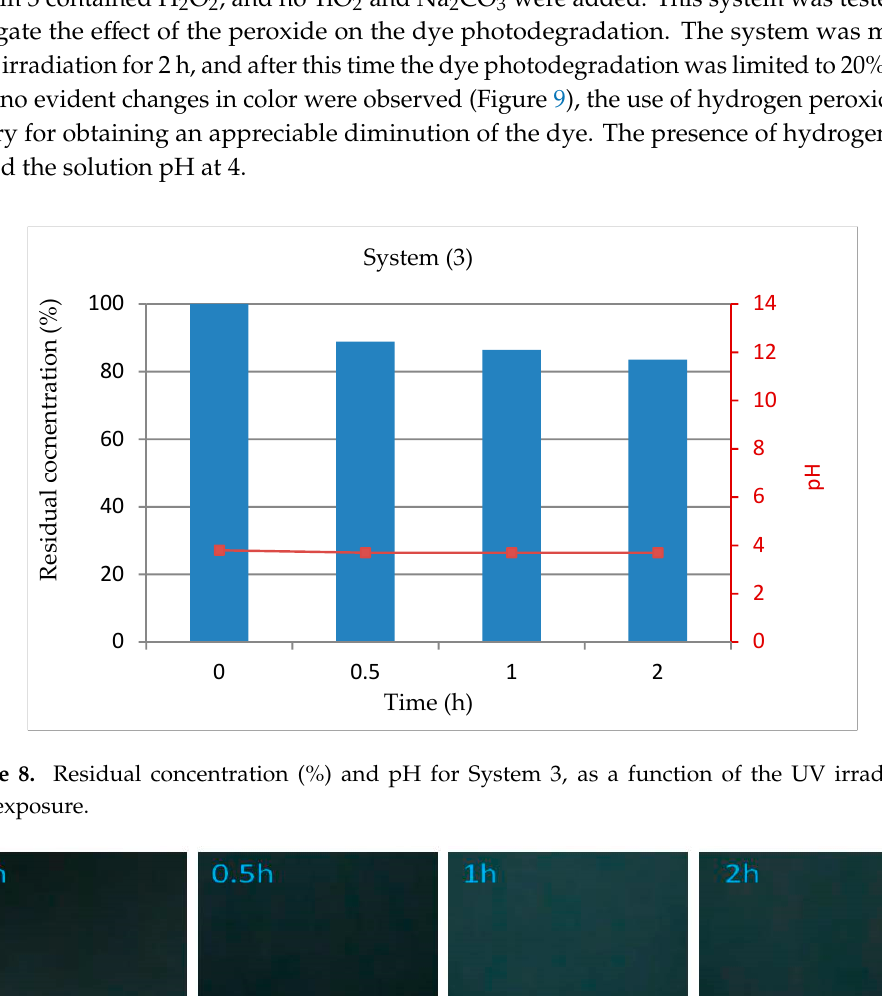
Figure 7. Variation of the color solution for System 2, as a function of the UV irradiation time exposure.